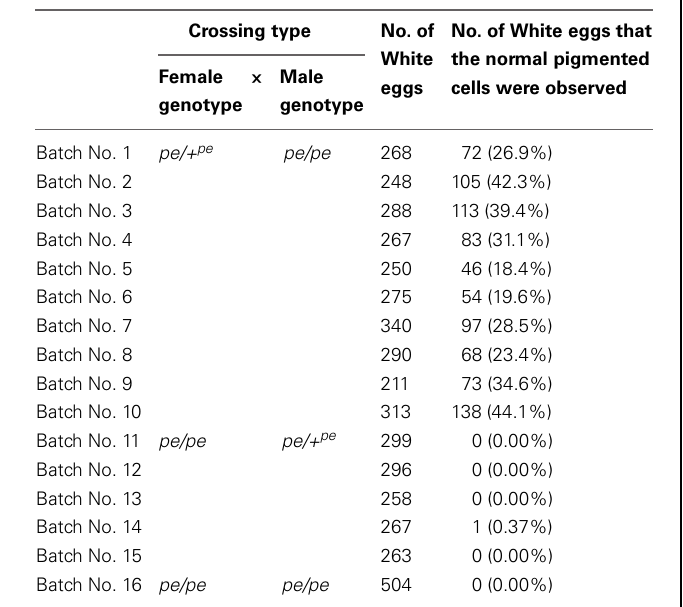
Table 2 | The number of white eggs carrying black pigmented serosal cells.